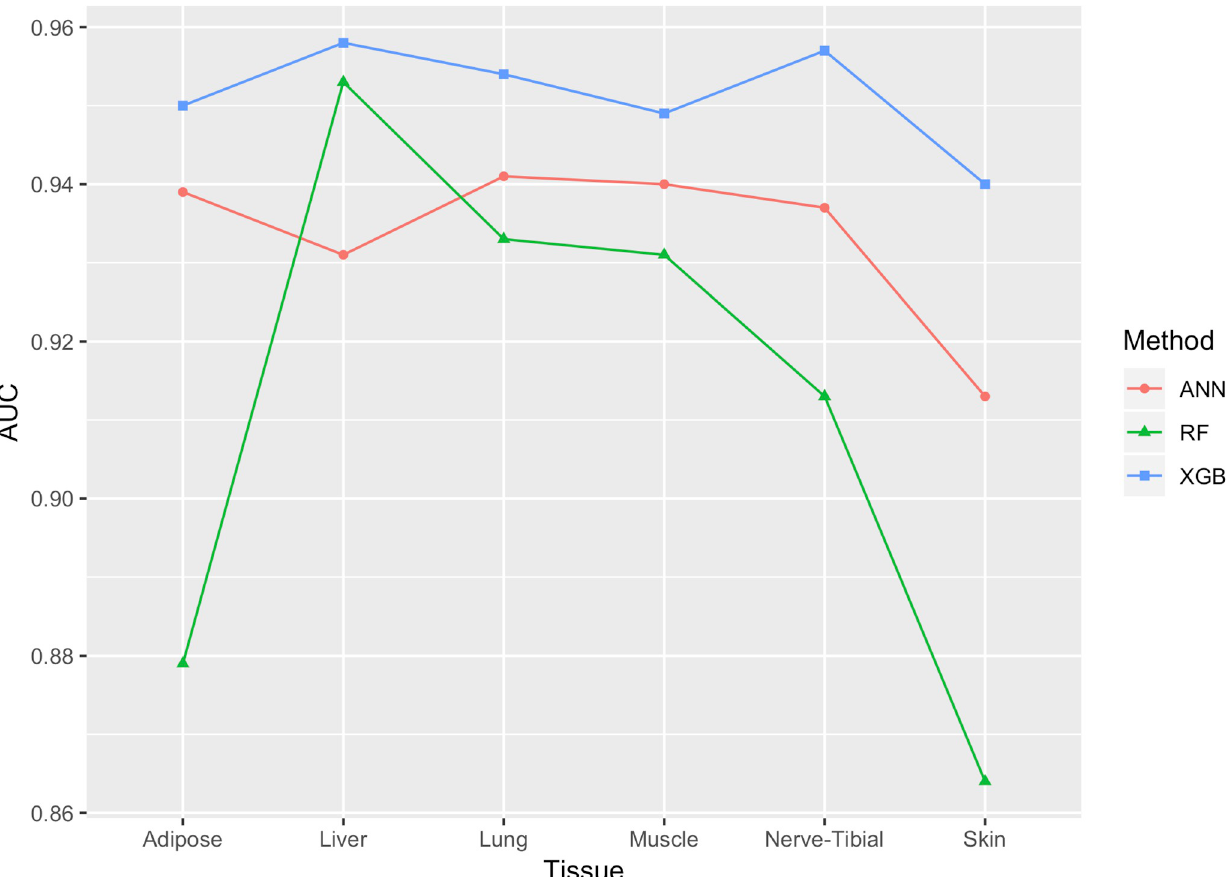
Fig 1. AUC comparison of the 18 classifiers. It can be seen that the XGBoost model outperforms the RF and ANN models for the six tested tissues.